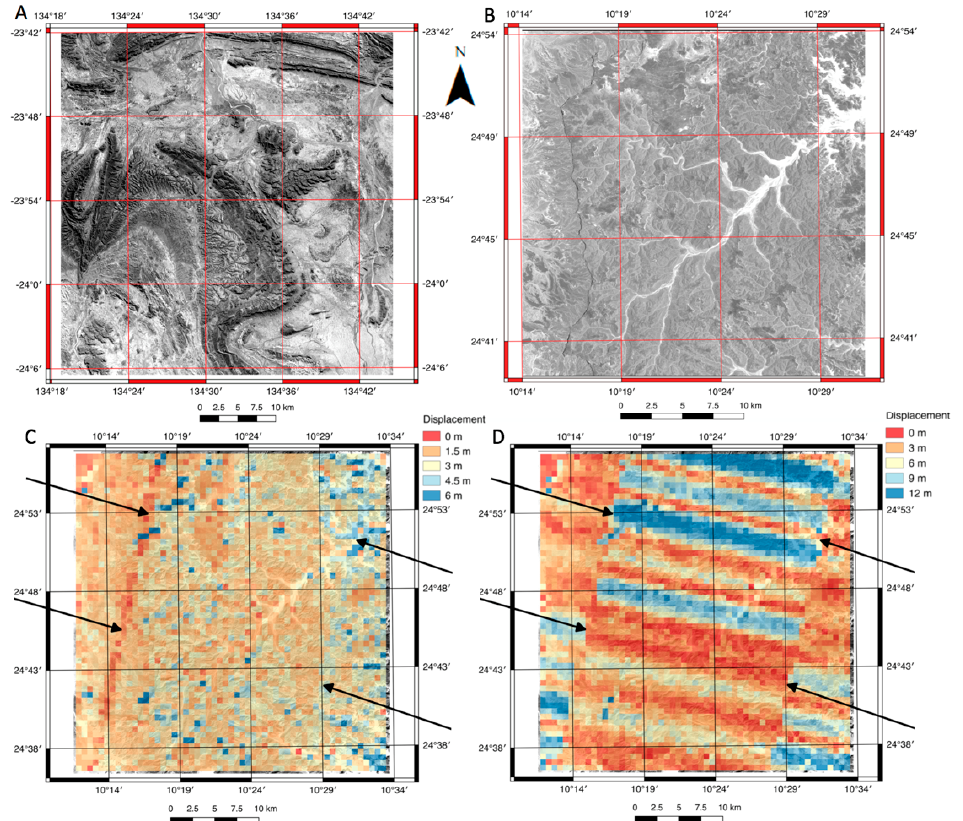
Figure 4. ( A ) Stable area in Australia; ( B ) Stable area in Libya; ( C ) Map of displacement of pair 04.01.2016–14.01.2016 over the stable area in Libya displaying striping in the orbit direction; ( D ) Map of displacement of pair 06.09.2016–06.10.2016 over the stable area in Libya displaying bands of differential displacement in the cross orbit direction. Arrows in ( C ) and ( D ) indicate position of striping in the along track direction.